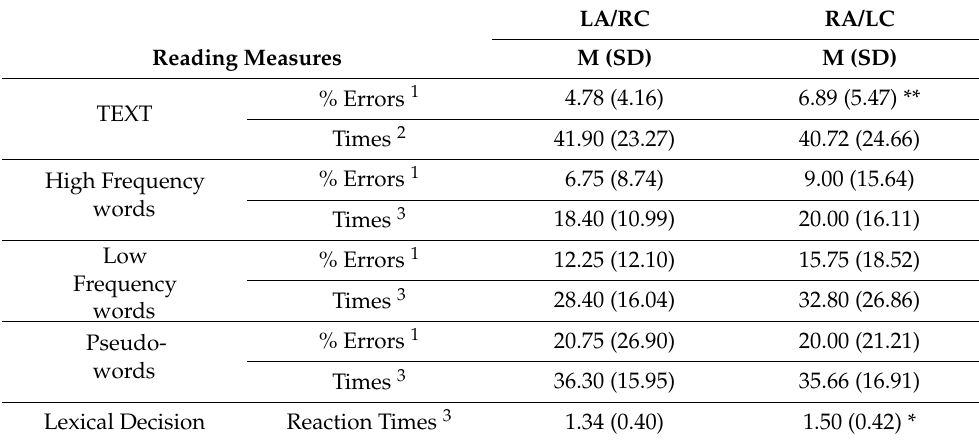
Table 1. Mean (SD) of each reading measure and lexical decision task for LA/RC and RA/LC condi-